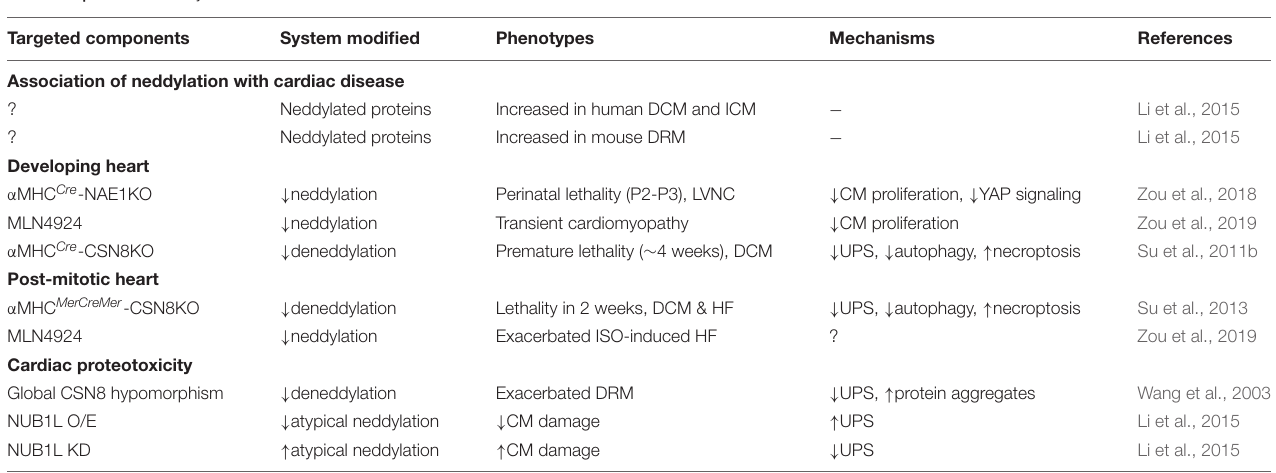
TABLE 1 | Roles of neddylation in the